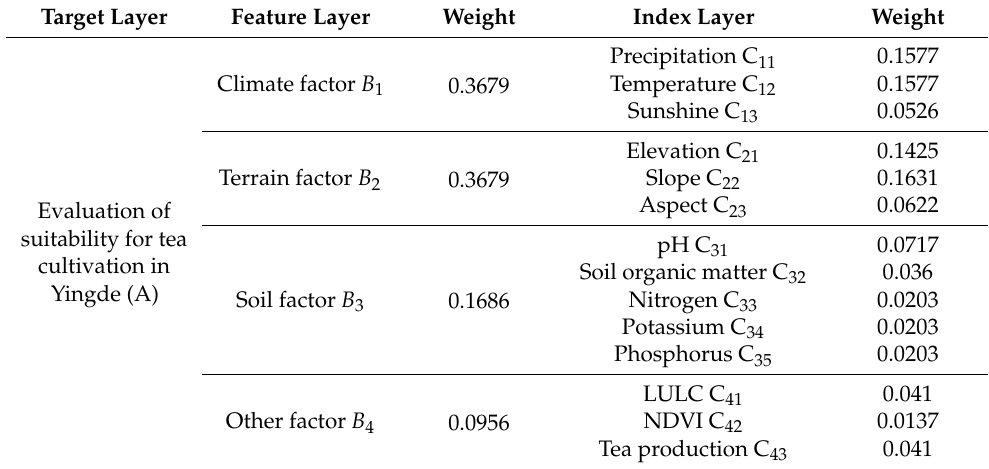
Table 3. The evaluation index of tea cultivation suitability evaluation and its weight value.